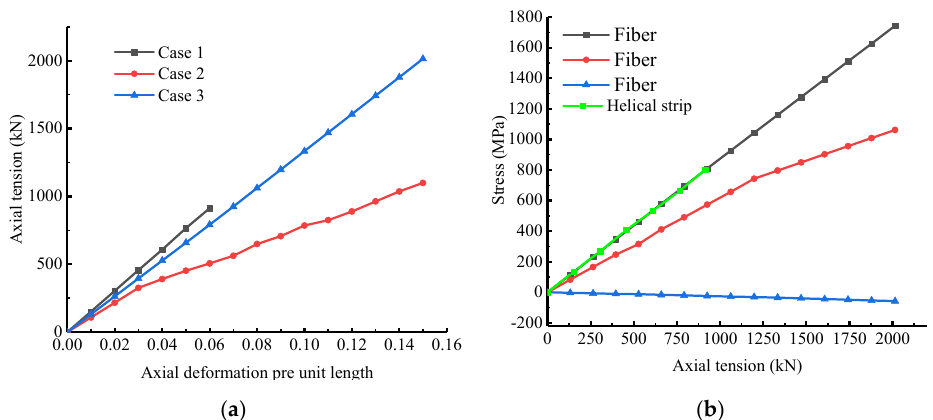
Figure 9. Axial deformation versus tension per unit length and stress of tensile armor. ( a ) Axial deformation versus tension per unit length; ( b ) the stress of tensile armor versus tension per unit length.